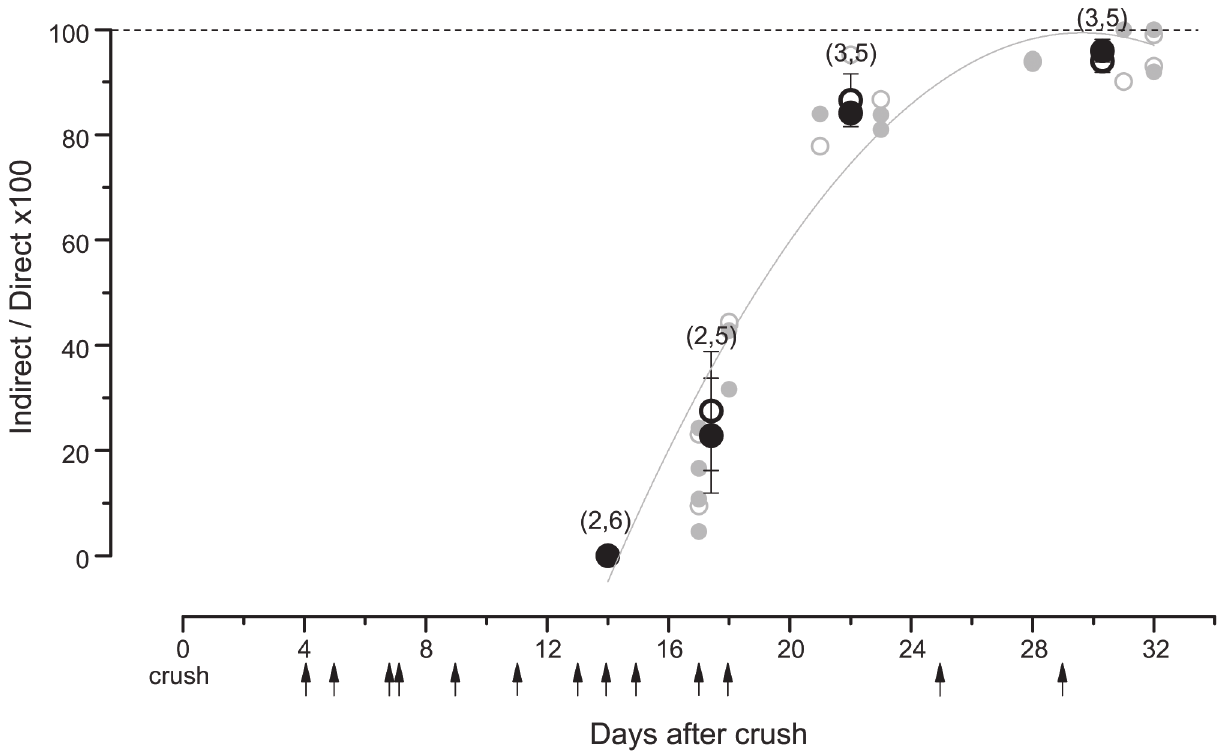
Fig 1. Time course of rat hindlimb muscle reinnervation after crush of the sciatic nerve. The percent reinnervation is obtained by comparing maximal twitch and tetanic isometric contractions elicited by nerve (indirect) electrical stimulation with those obtained, under curare, by muscle (direct) stimulation. The muscles investigated are soleus, extensor digitorum longus (EDL) and tibialis anterior (TA), from a series of 10 rats, utilized only for determining the time course of reinnervation. Filled and open gray dots (twitch and tetanus, respectively) are the individual data from all muscle types. Filled and open black dots (twitch and tetanus, respectively) represent the average ( ± SE) at different time points of reinnervation after crush (in brackets: number of rats, number of muscles). The gray line is the polynomial fitting curve of individual twitch data (r = 0.97; that for tetanus data, also with r = 0.97, not shown).The arrows under the abscissa indicate the times after crush when we investigated, in another series of animals, the possible development of electrical coupling between motor neurons during regeneration of their axons.